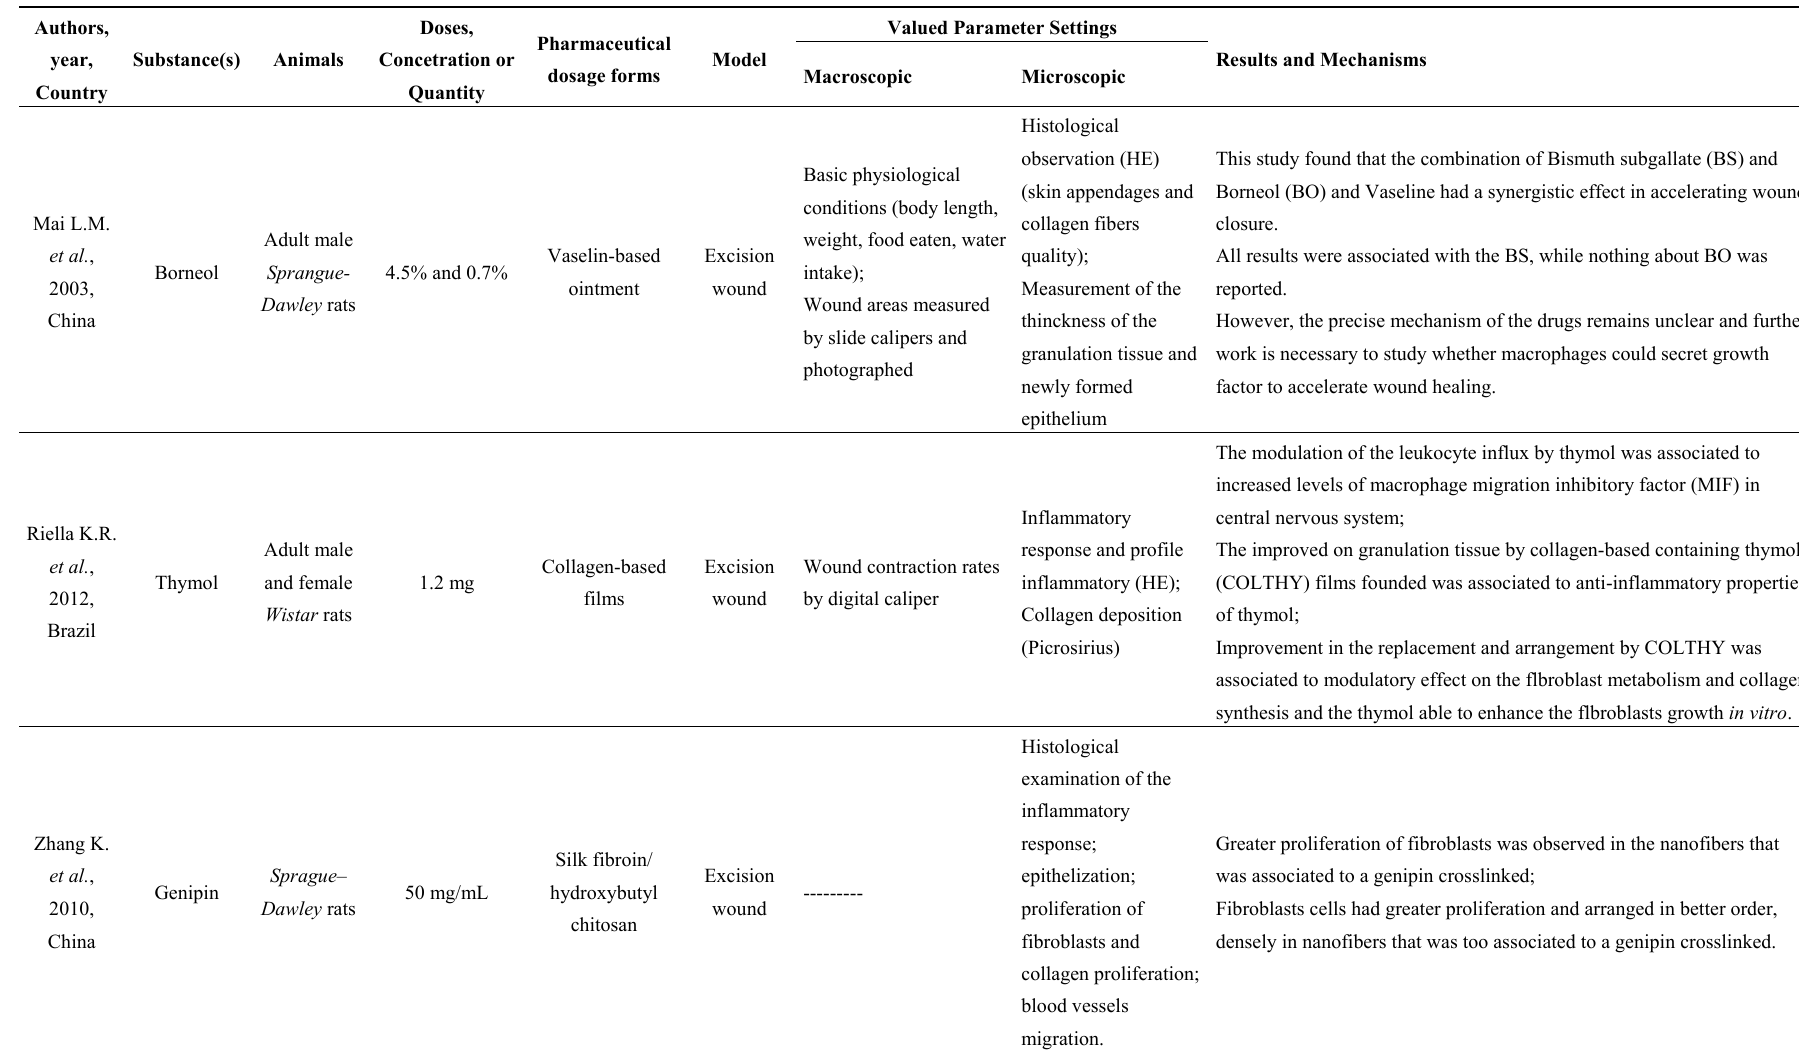
Table 1. Characteristics of included